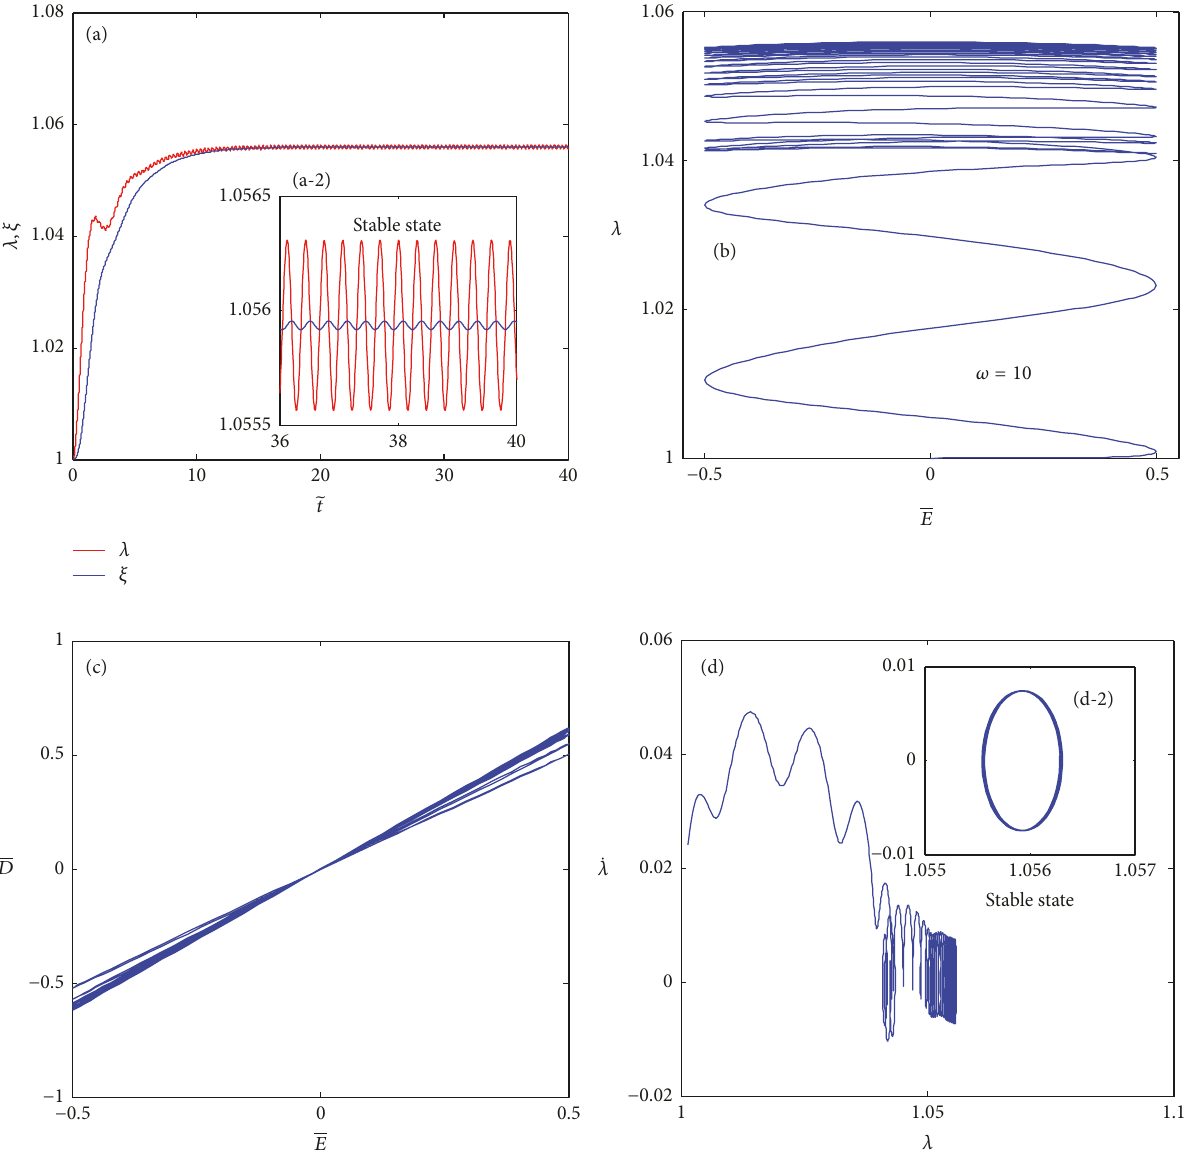
Figure 4: The total stretch 𝜆 the viscous stretch 𝜉 (a), the nominal electric field-stretch response (b), the nominal electric field-nominal electric displacement (c), and the phase diagram (d) for the dimensionless frequency Ω = 10